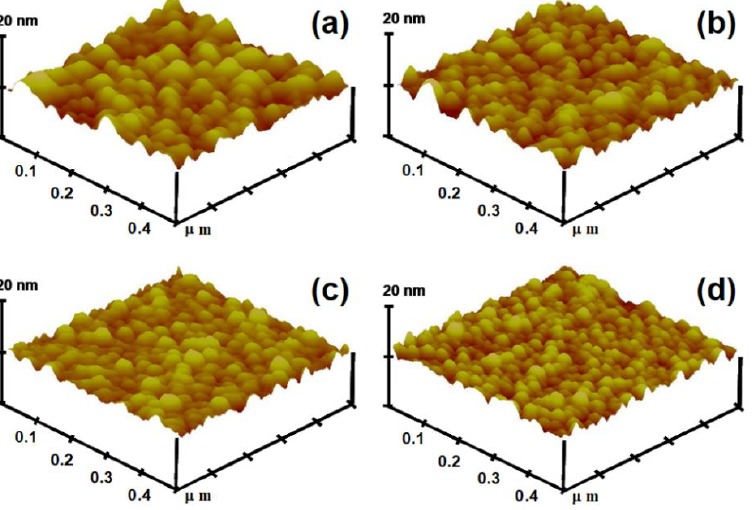
Figure 3. Topographic scanning probe microscope (SPM) micrographs of ZnO-based thin films: ( a ) ZnO, ( b ) ZnO:Al, ( c ) ZnO:Al-1% B and ( d ) ZnO:Al-2% B thin films.